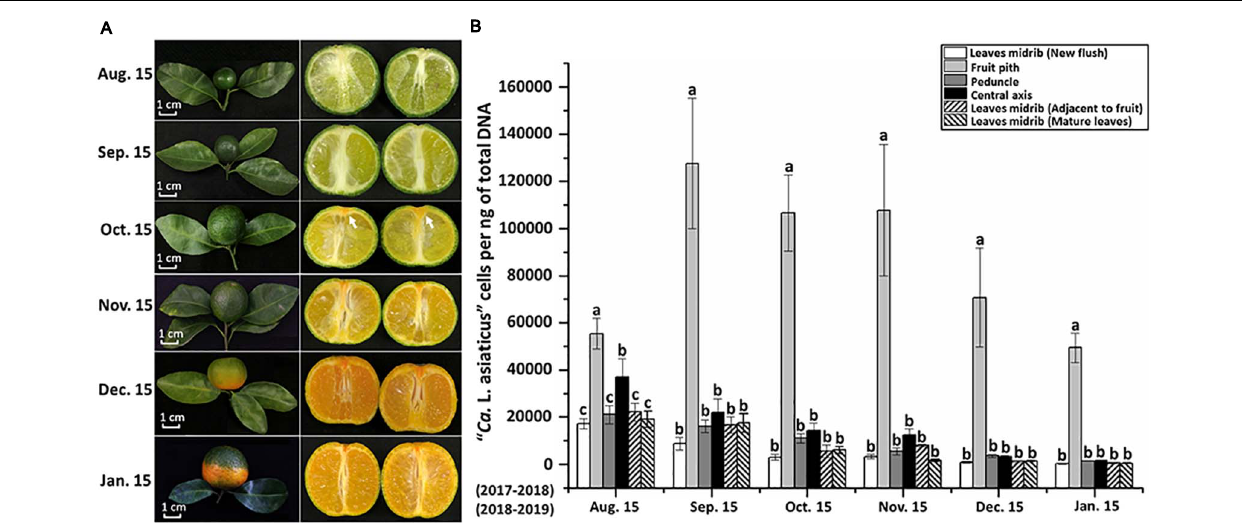
FIGURE 1 | Quantitative distribution off “ Candidatus f Liberibacter asiaticus” (CLas) in citrus branches and fruits. (A) Symptom development of HLB-affected “Shatangju” mandarin ( Citrus reticulata Blanco “Shatangju”) fruits. (B) Temporal dynamics of CLas population in different parts of HLB-affected “Shatangju” branches. Ten citrus branches were monthly collected from HLB-affected citrus trees during August 15, 2017, to January 15, 2018, and August 15, 2018 to January 15, 2019. Note the vascular columella (white arrow) under the peduncle of diseased fruit started to turn into orange in October.